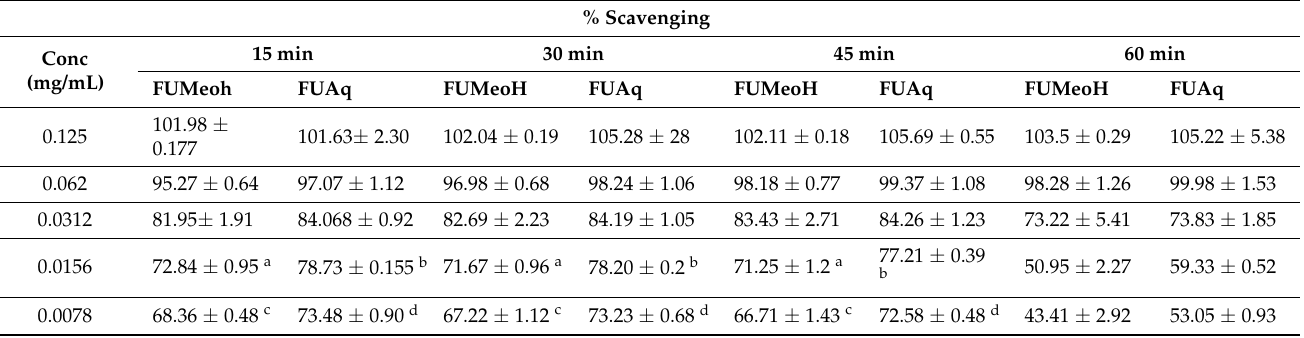
Table 2. ABTS scavenging activity of Ficus umbellata